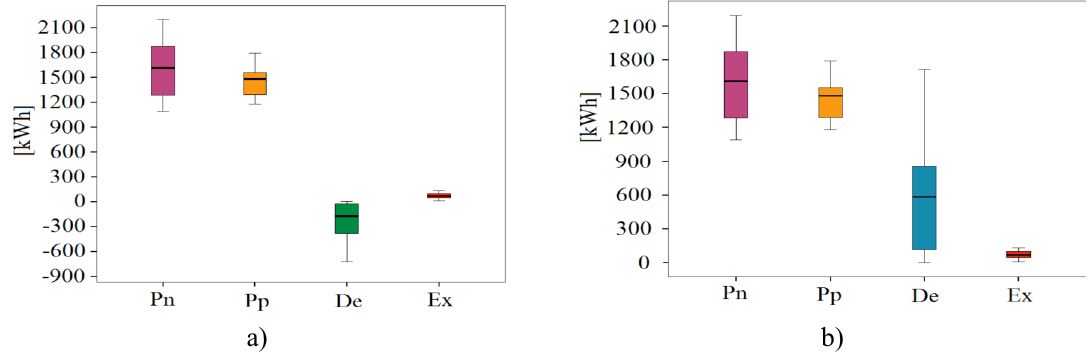
Fig. 4. Maximum consumption for location chosen: (a) solution 1, (b)